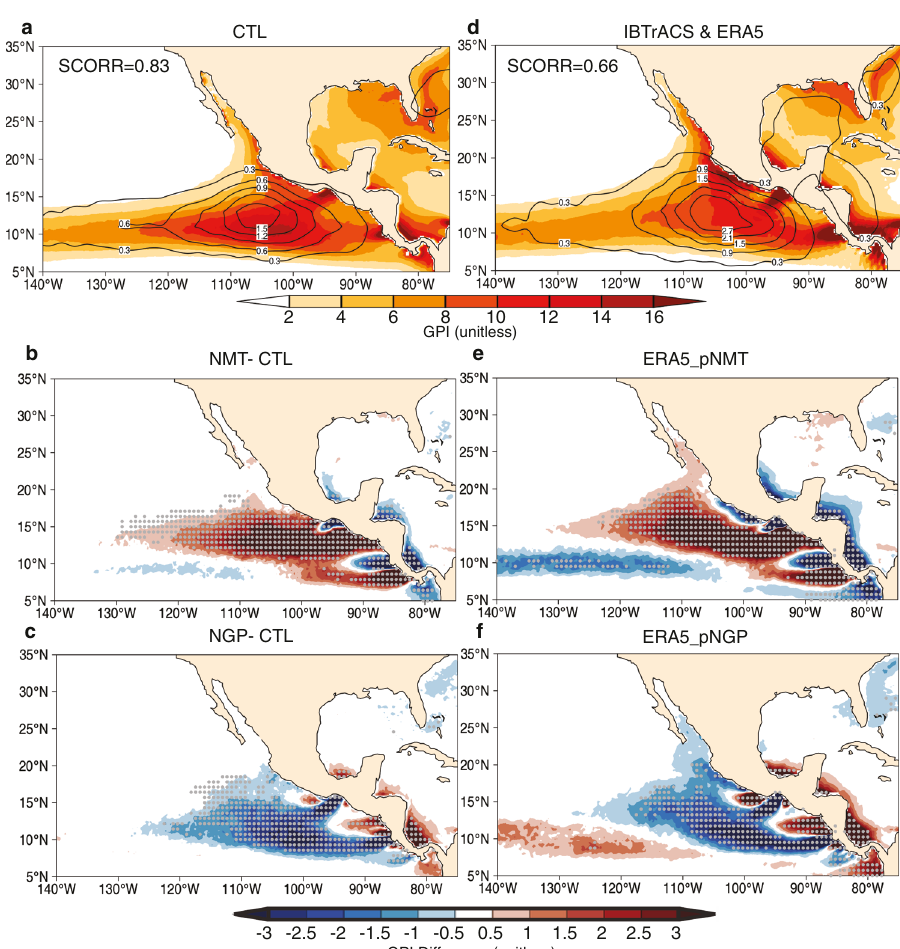
Fig. 3 Topography modulates large-scale environmental favorability for seasonal TC genesis. a Control (CTL) ensemble mean of genesis potential index (GPI; unitless; color shadings) and TC genesis density (occurrence number decade − 1 ; contour starting from 0.3 with the interval of 0.3). The differences of genesis potential index using b no mountains (NMT) minus CTL and c no mountain gaps (NGP) minus CTL. d Similar to ( a ), but for 1990 – 2018 mean genesis potential index from ERA5 reanalysis data (unitless; color shadings) and TC genesis density from the IBTrACS observation data (occurrence number decade − 1 ; contour starting from 0.3 with the interval of 0.6). The spatial correlation coef fi cients (SCORR) between TC genesis density and genesis potential index are listed on the top left of panels. e , f Similar to ( b , c ), but the GPI difference in “ pesudo-no mountains ” (pNMT) and “ pseudo-no-gaps ” (pNGP) experiment (see details in “ Methods ” ). Gray dots denote statistical con fi dence at the 95% level based on the two-sided t